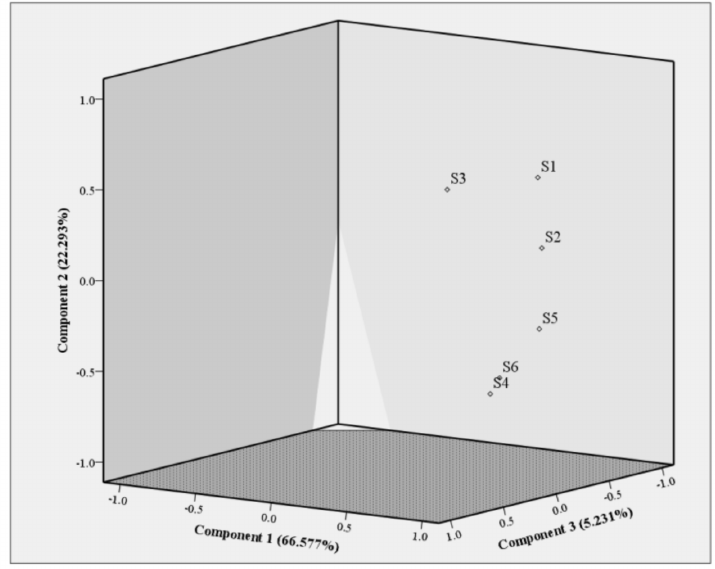
Figure 3. PCA plot of the pine leaf samples. S1–S6 represented P. sylvestris , P. tabuliformis , P. bungeana , C. deodara , P. densiflora , and P. thunbergii respectively.